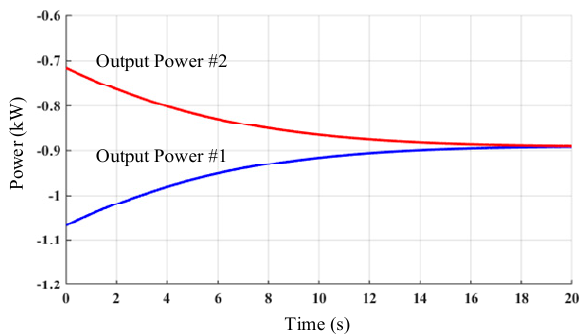
Figure 10. Waveforms of charging power.